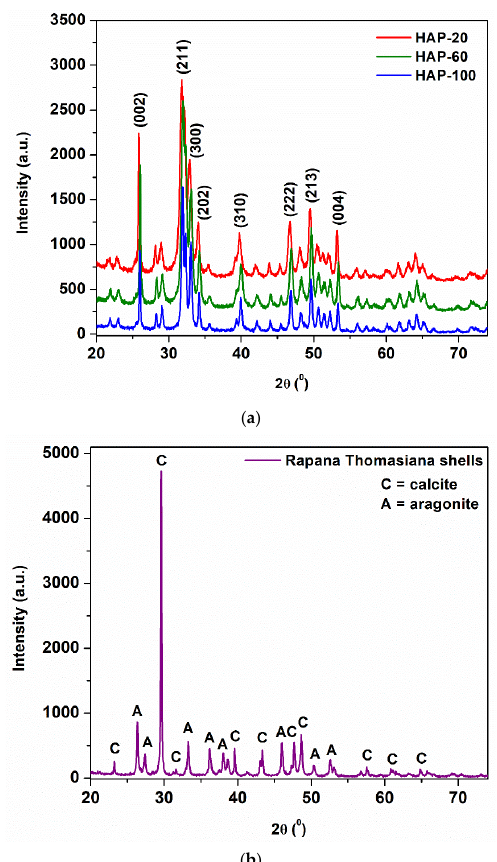
Figure 2. ( a ) XRD spectra of HAp nanopowders; ( b ) XRD spectrum of Rapana Thomasiana shells. Table 4. Scherrer crystallite size, BET average particle size, and hydrodynamic diameter of HAP